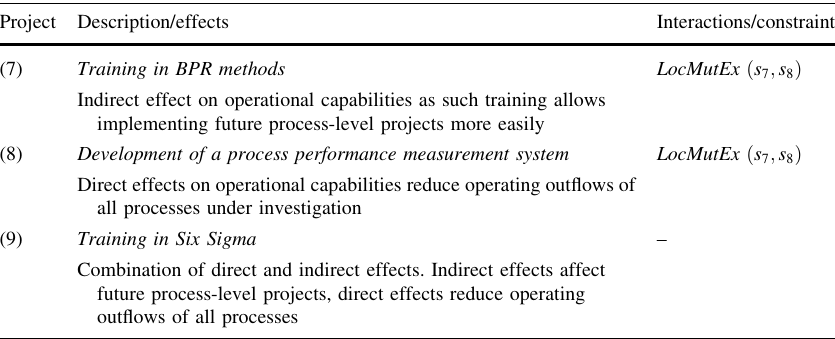
Table 6 BPM-level projects considered in the case Project